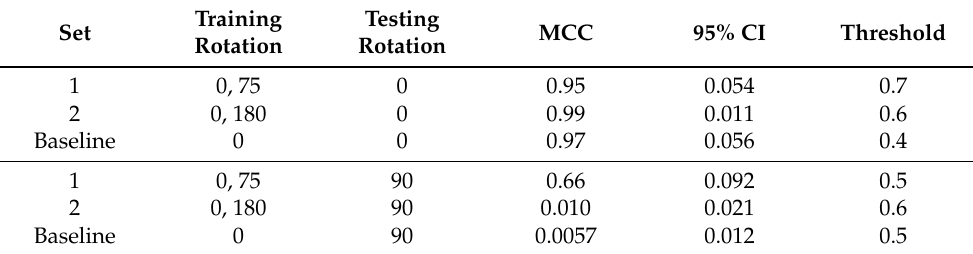
Table 7. S-band results tabulating unet model training data, testing data, the peak MCC performance with 95% confidence interval (CI), and the corresponding threshold.